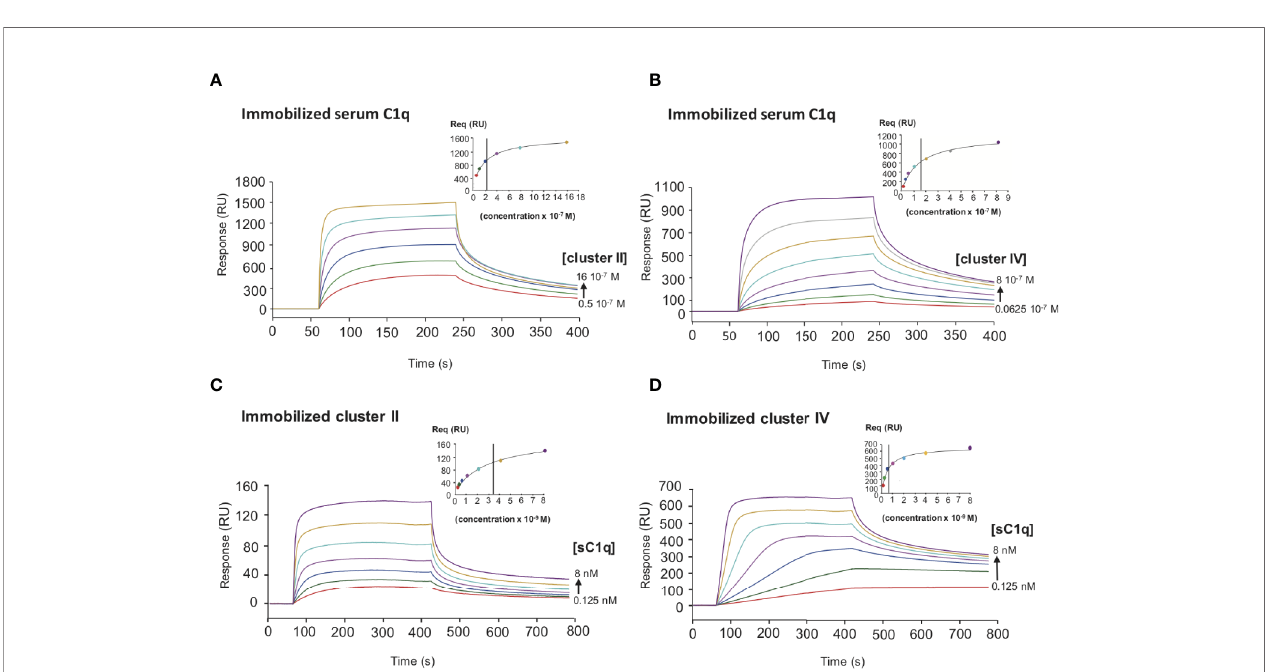
FIGURE 5 | Comparative kinetic analysis of the interaction of serum C1q with LRP1 clusters II and IV. SPR analysis of LRP1 clusters II and IV interactions with serum C1q in two con fi gurations. Top panels, clusters II and IV were injected over immobilized serum C1q (14,000 RU), (A, B) respectively. Bottom panels, serum C1q was injected over immobilized clusters II (1,230 RU) and IV (1,270 RU), (C, D) respectively. All injection were performed in 50 mM Tris, 150 mM NaCl, 2 mM CaCl 2 , 0.05% P20, pH 7.4. The concentration of soluble ligands is indicated on each curve. The Req versus concentration plots of steady state fi ttings are shown on the top right of the SPR curves. K D values (means ± SD) for each kinetics are summarized in Table 2